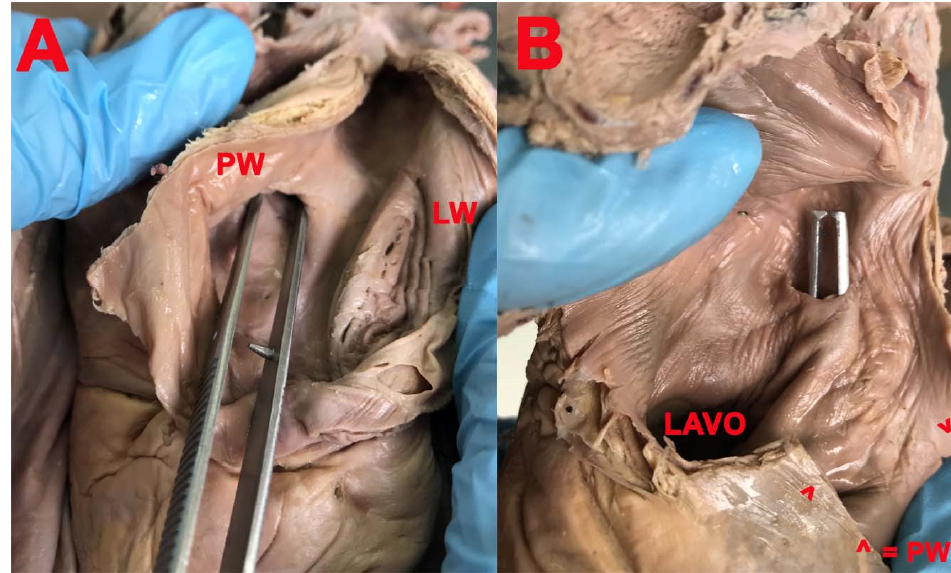
Figure 6. ( A , B ): PFO. ( A ): PW —posterior wall; LW —lateral wall. ( B ): LAVO —left atrioventricular orifice; PW —posterior wall.